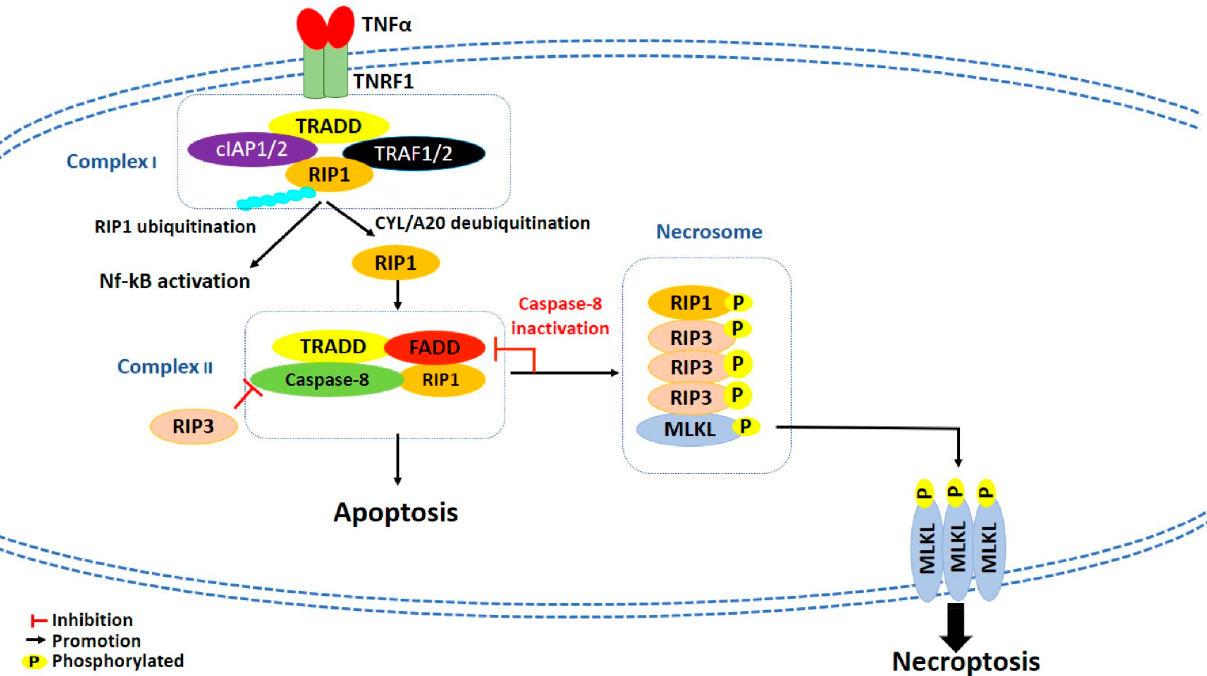
Figure 2. Schematic representation of necroptotic cell death pathway. cIAP1/2: Cellular inhibitors apoptosis proteins; CYL: Cylindromatosis; FADD: Fas-associated death domain; MLKL: Mixed lineage kinase domain-like; Nf-kB: Nuclear factor kappa-light-chain-enhancer of activated B cells; RIP1: Receptor-interacting protein 1; RIP3: Receptor-interacting protein 3; TNF α : Tumor necrosis factor alfa; TNFR1: Tumor necrosis factor receptor 1; TRADD: TNF Receptor-associated death domain; TRAF1/2: TNFR-associated factors 1/2.